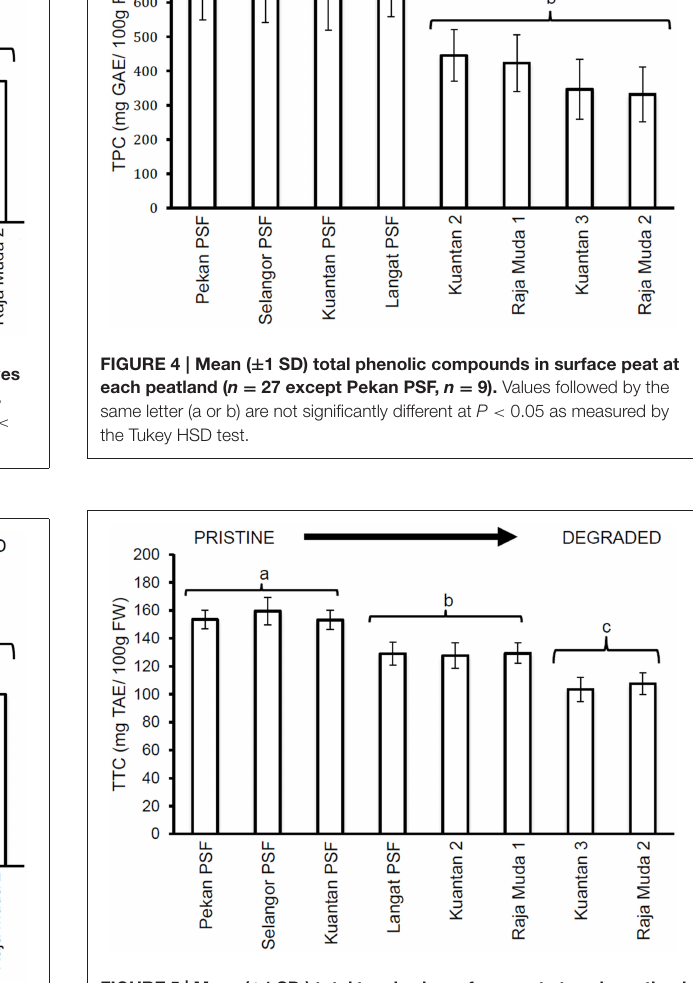
FIGURE 5 | Mean ( ± 1 SD.) total tannins in surface peat at each peatland ( n = 27 except Pekan PSF, n = 9). Values followed by the same letter (a–c) are not significantly different at P < 0.05 as measured by the Tukey HSD